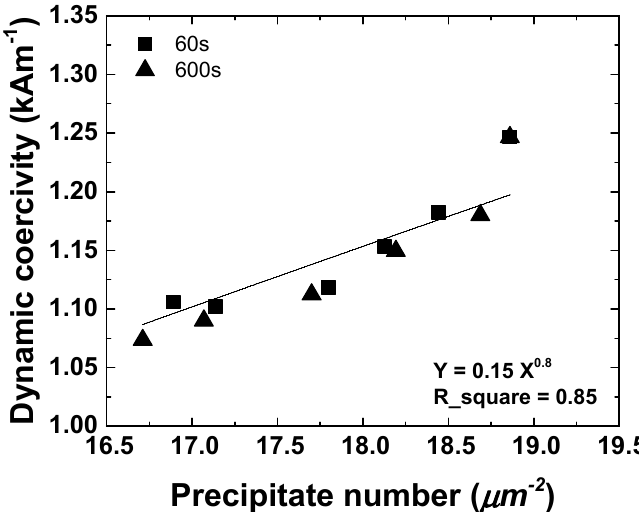
Figure 4. The interrelationship between dynamic coercivity and precipitate number which is fitted to a nonlinear curve by the allometric model (y = ax b ).